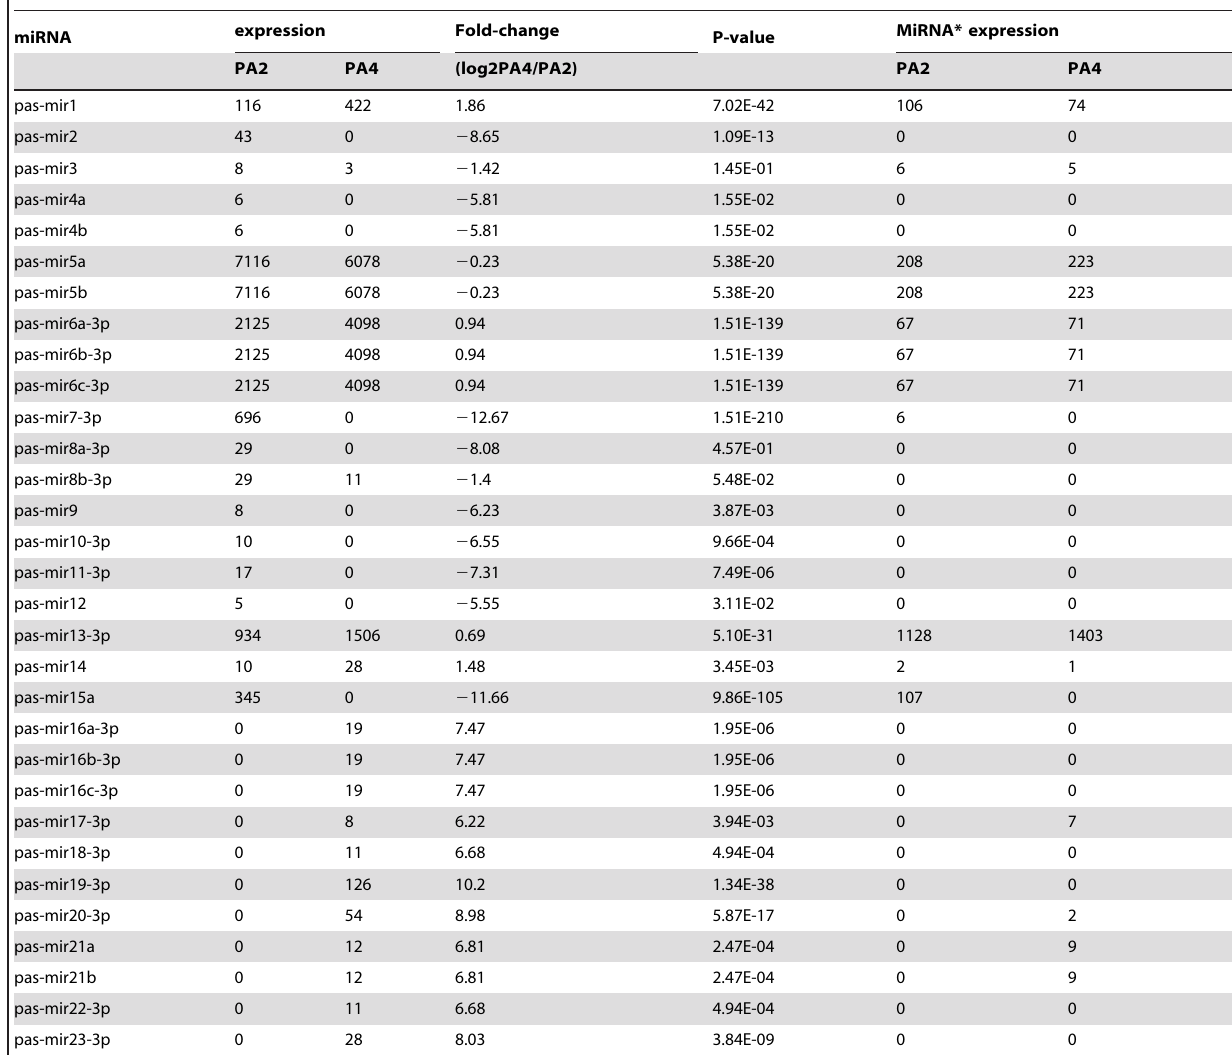
Table 2. Novel miRNAs identified from P. australis.